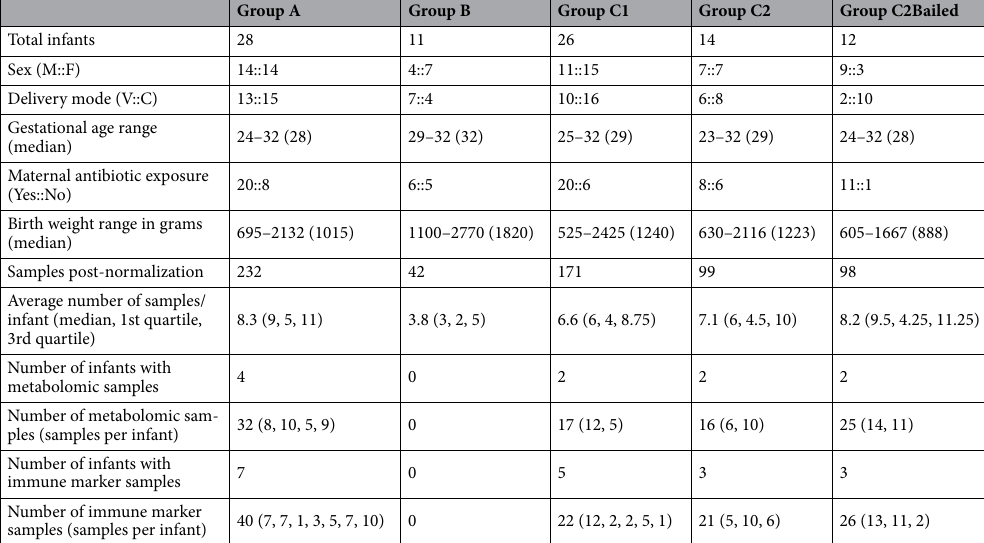
Table 1. Summary of infant enrollment, covariates, and samples. Summary of the number of enrolled infants per group used in this analysis and the number of infants changed from group C2 to C2Bailed. Enrollment groups are also summarized by infant sex (male::female), mode of delivery (vaginal::caesarean), gestational ages, maternal antibiotic exposure (yes::no) and birth weight ranges in grams. The number of infants and number of stool samples used in the metabolomics and immune marker analyses are listed.